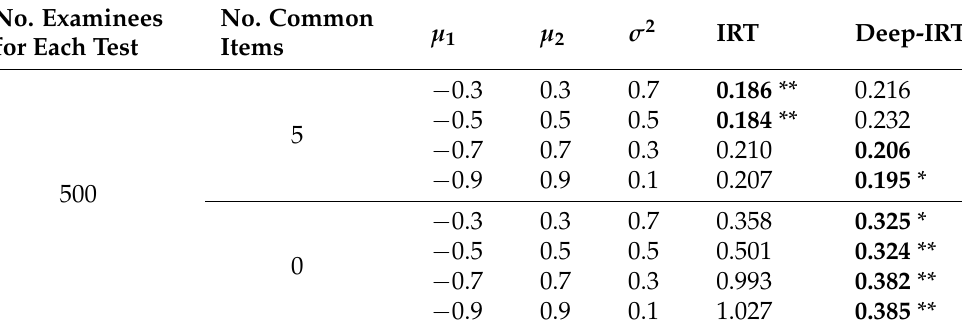
Table 3. Estimation accuracies for multi-population